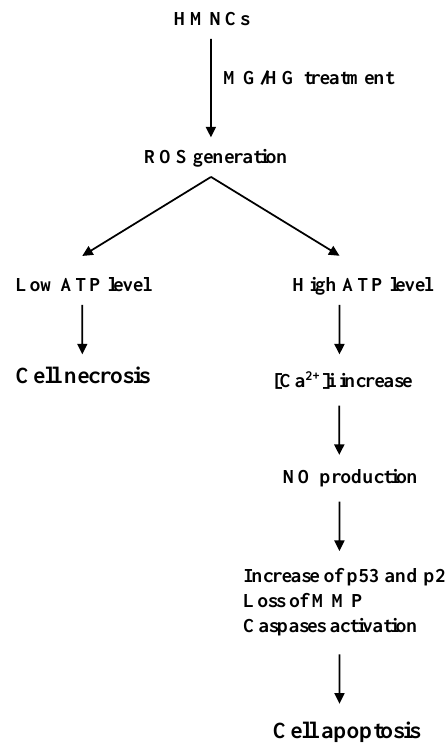
Figure 8. Scheme of events occurring during MG/HG-induced cell death in